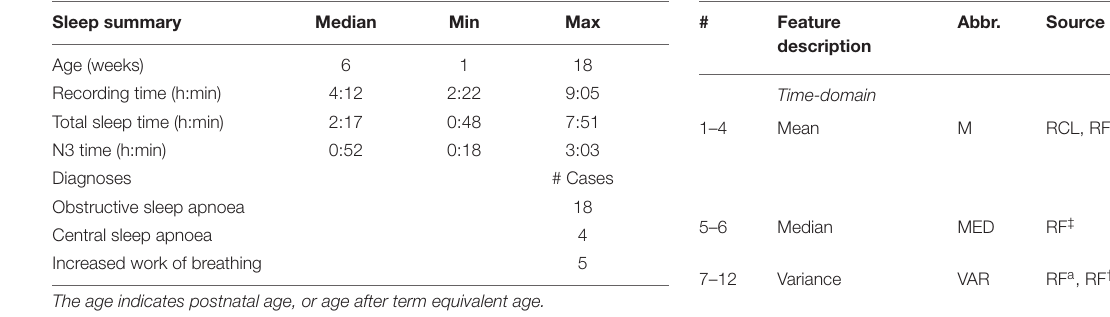
TABLE 1 | Summary of the participants. TABLE 2 | Computational features used in the SVM and LSTM